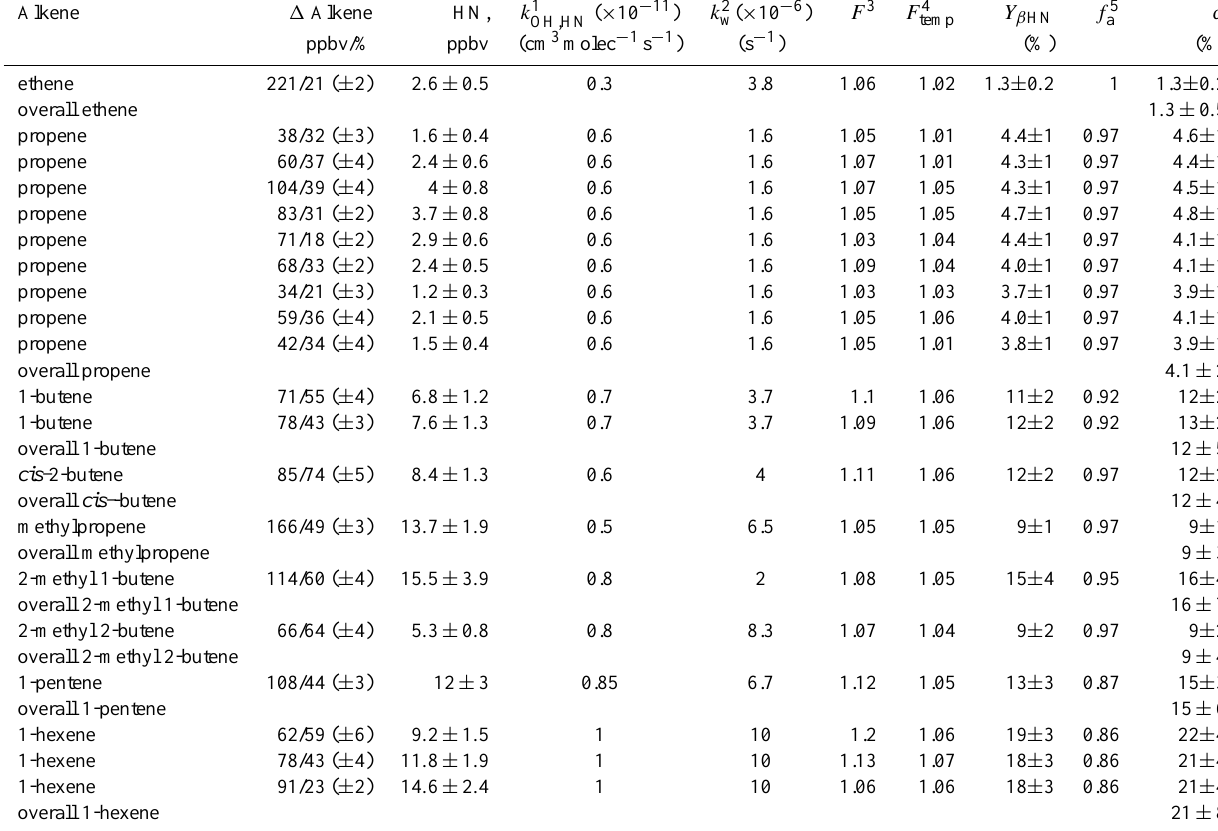
Table 3. Absolute hydroxy nitrate (HN) yields from alkenes at 293K and 993hPa.